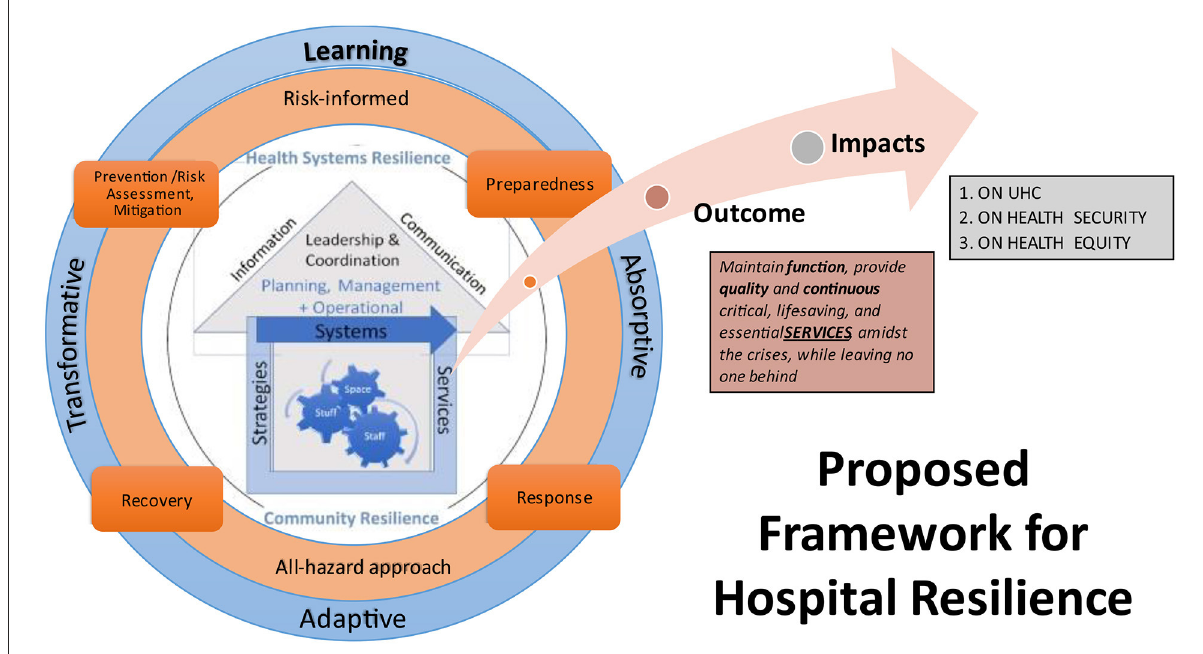
FIGURE6 Proposed conceptual framework for hospital